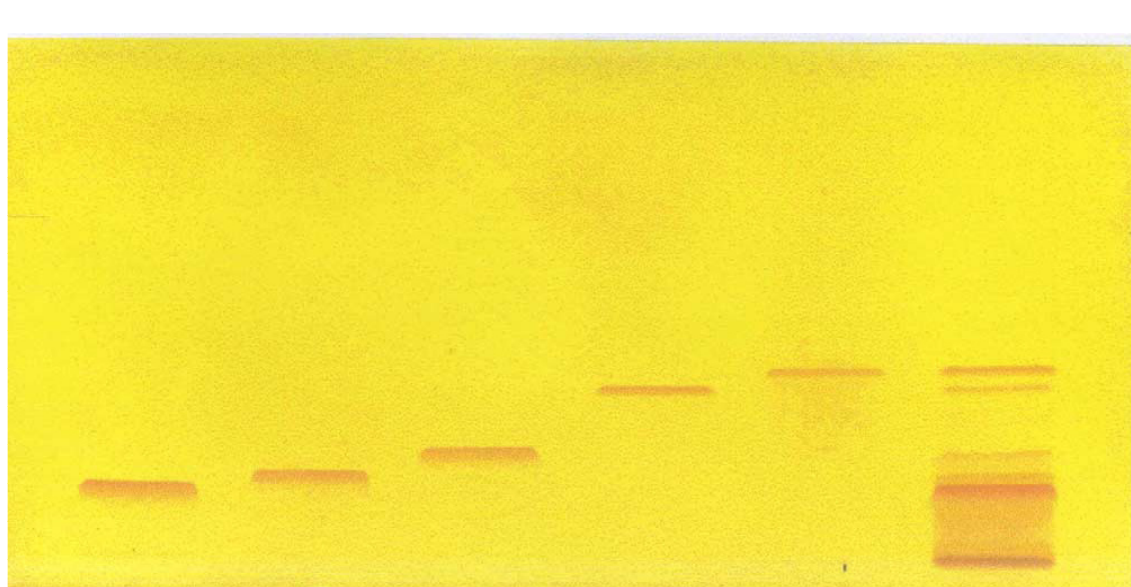
Figure 4. HPTLC chromatogram by AMD of opium extract and standard alkaloids of opium: (1) morphine; (2) codeine; (3) thebaine; (4) papaverine; (5) noscapine; (6) opium extract; eluent used was universal gradient: methanol 100, methanol–dichloromethane 50/50, dichloromethane